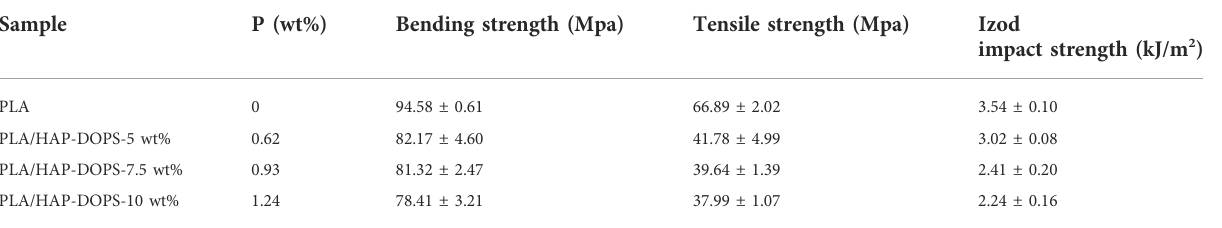
TABLE 3 Mechanical property test data of PLA and PLA